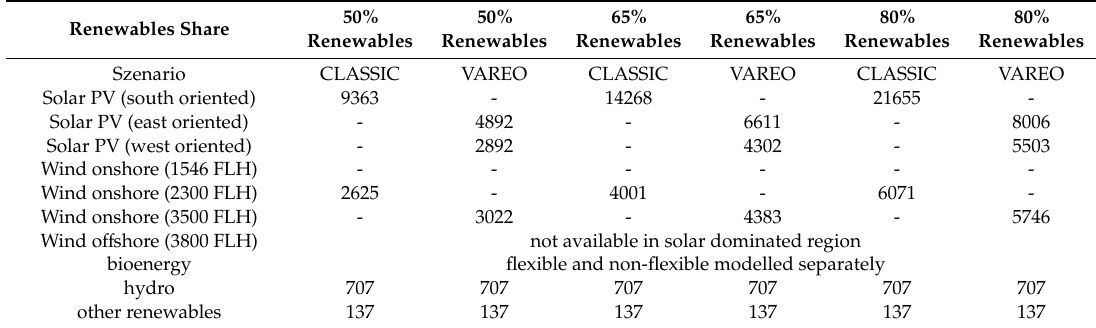
Table A1. Installed renewable capacities for the investigated wind solar PV-dominated region.